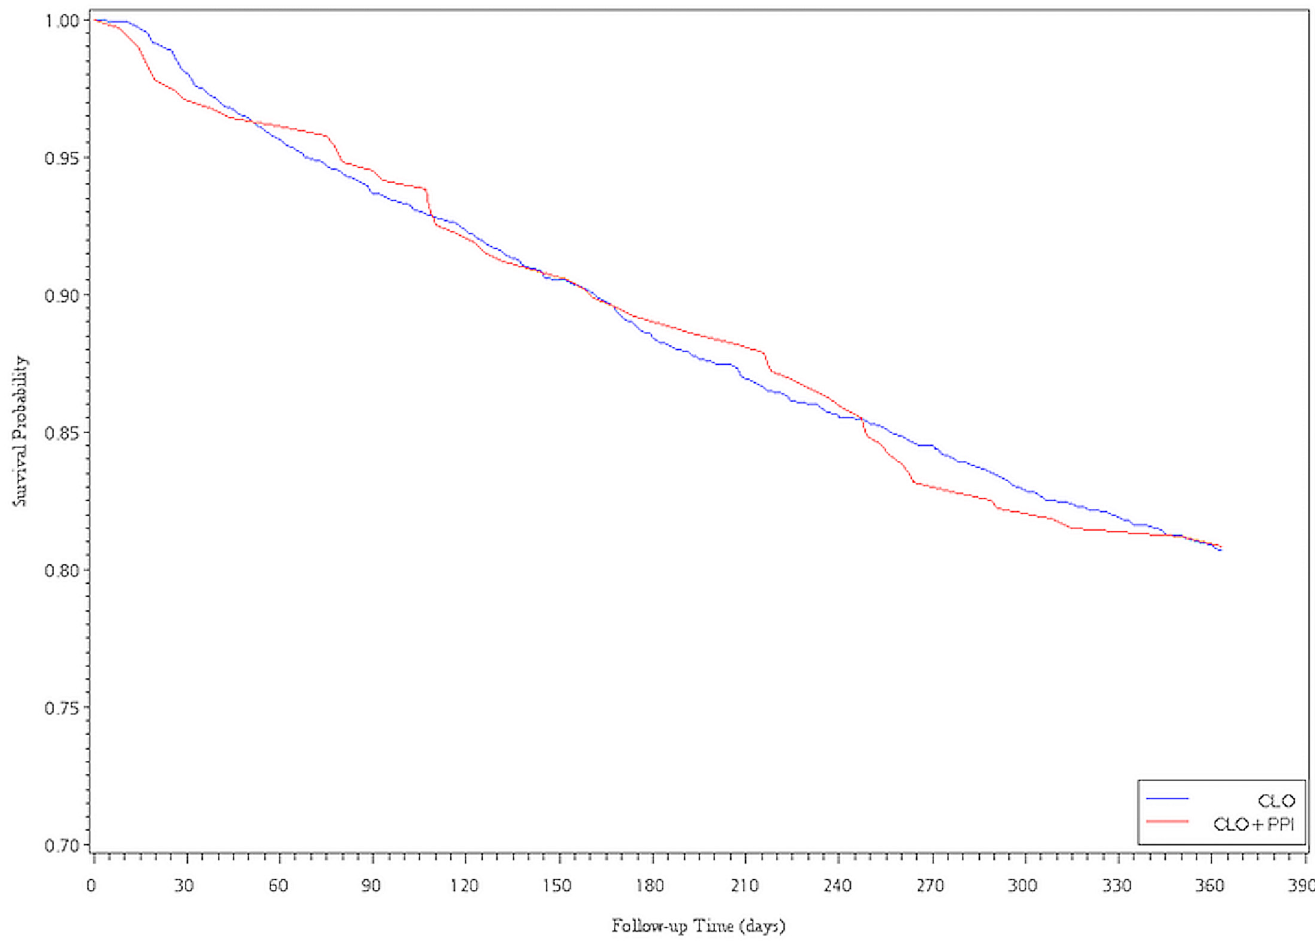
Fig 3. Survival analysis of revascularization versus exposure to ClO plus PPI and ClO after PES implantation.